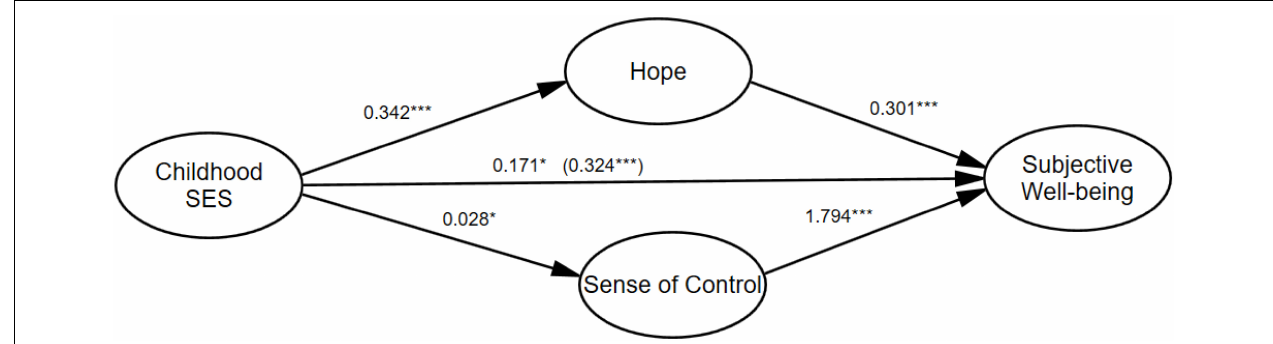
FIGURE 2 | Unstandardized estimated path coefficients of the structural equation model. N = 568. Model 1: Childhood SES → Subjective Wellbeing (without mediator). Model 2: Childhood SES → Hope + Sense of Control → Subjective Wellbeing. The numbers represent the beta coefficients for Model 2. The beta coefficients for Model 1 are in parentheses. *** p < 0.001, * p <